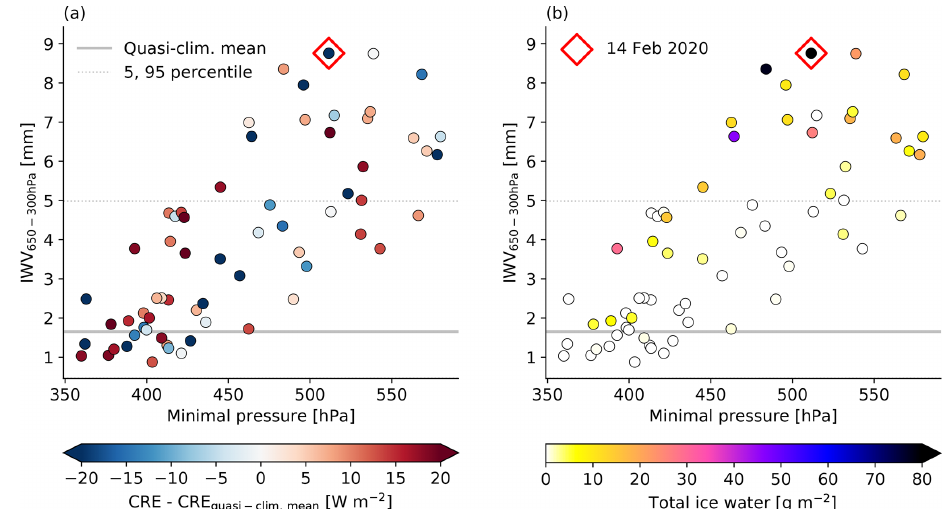
Figure 17. The relation between daily mean IWV 650–300hPa , the mean of the minimal pressure reached during the 10d journey by the trajectories fulfilling the tropical detrainment criteria, and (a) the anomaly in daily mean CRE relative to the quasi-climatological mean or (b) daily mean total ice water at the BCO is shown for the 65 TMD days. The quasi-climatological means are shown as continuous gray lines, and the 5th and 95th percentiles are shown as dashed gray lines. The red rhombus indicates 14 February 2020. Note that the daily mean values are based on 3-hourly data; thus, the values are not directly comparable to Fig. 13. Data: